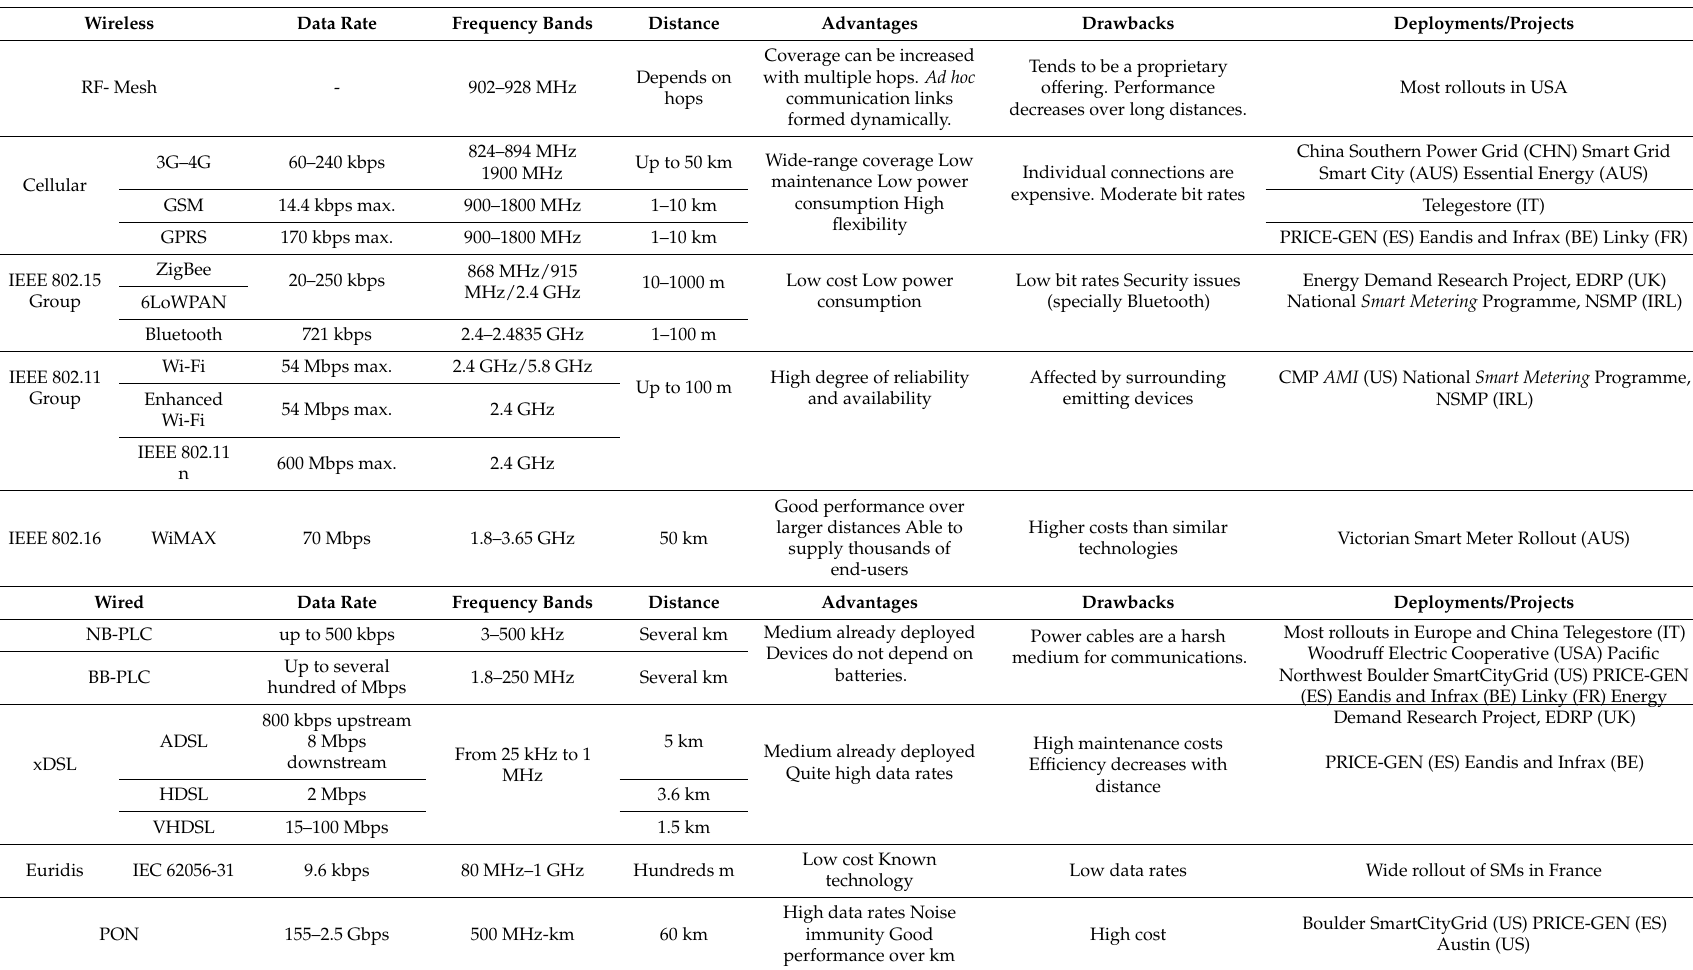
Table 3. Main technologies and features for Smart Metering